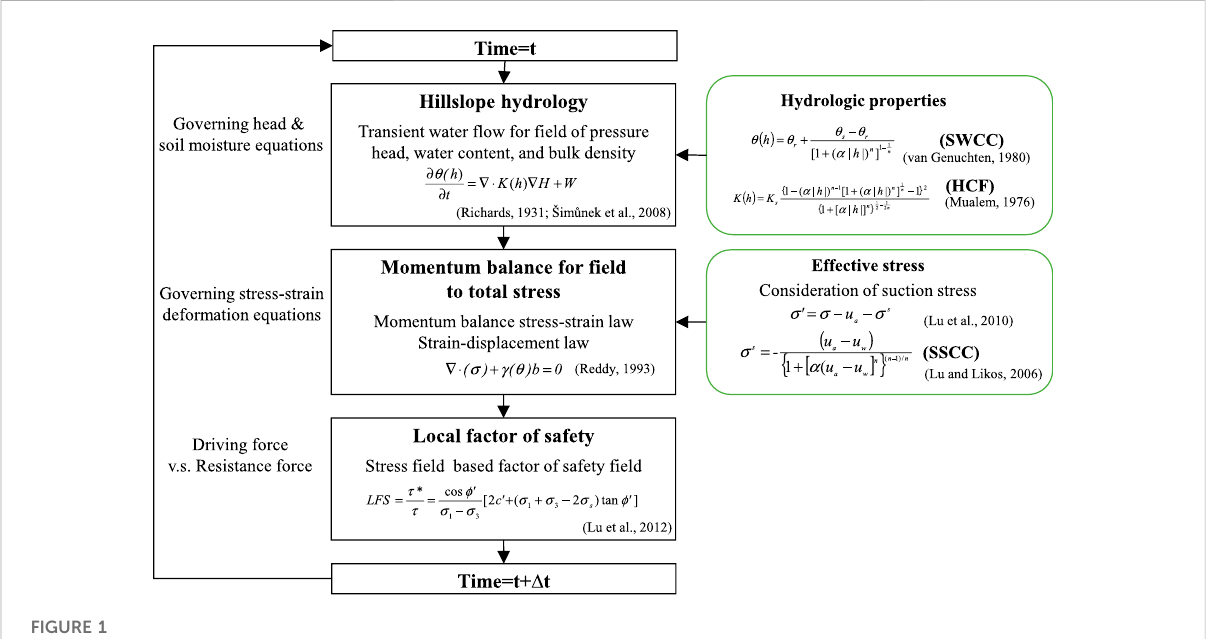
FIGURE 1 Flowchart of one way coupled hydro-mechanical calculation in this